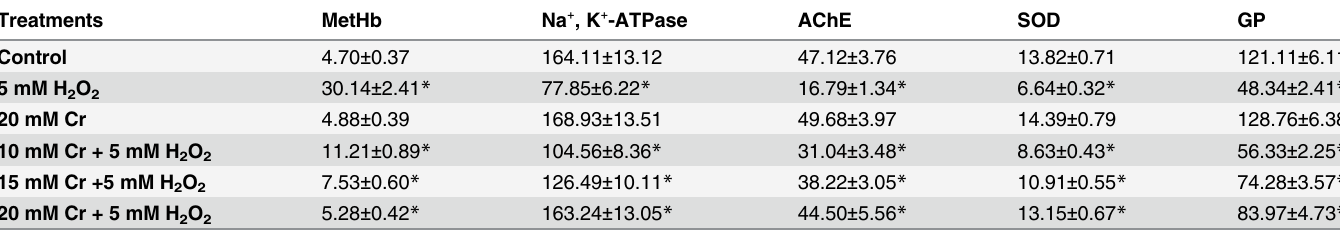
Table 1. Effect of creatine on H 2 O 2 -induced changes in methemoglobin levels, activity of erythrocyte membrane bound and antioxidant enzymes.